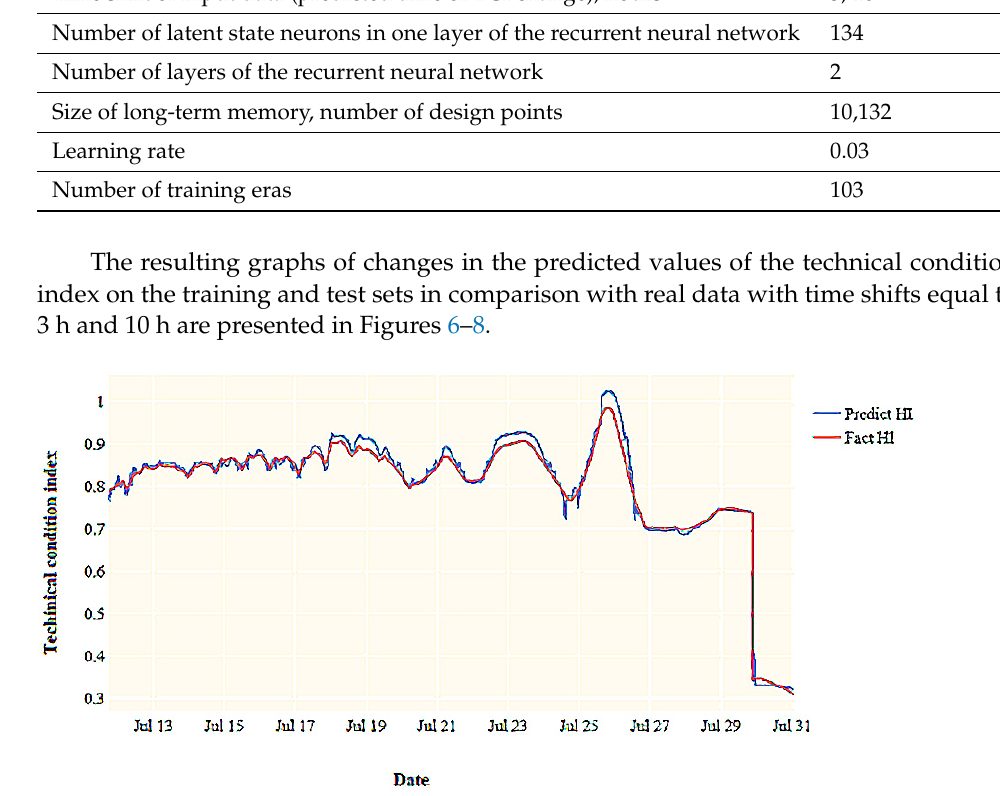
Table 3. Values of the optimal hyperparameters of the tuned LSTM model of the recurrent neural network.